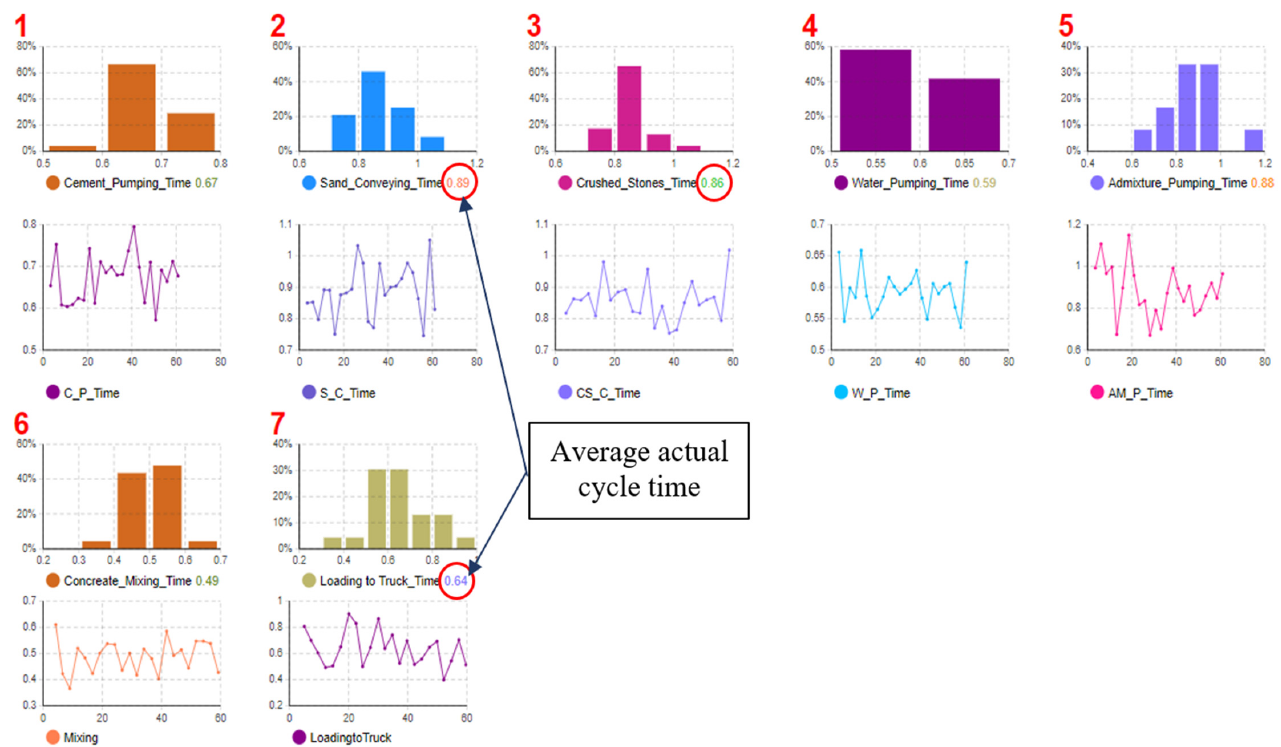
Figure 17. Sub-Production Operation Actual Cycle Time and Its Behavior.